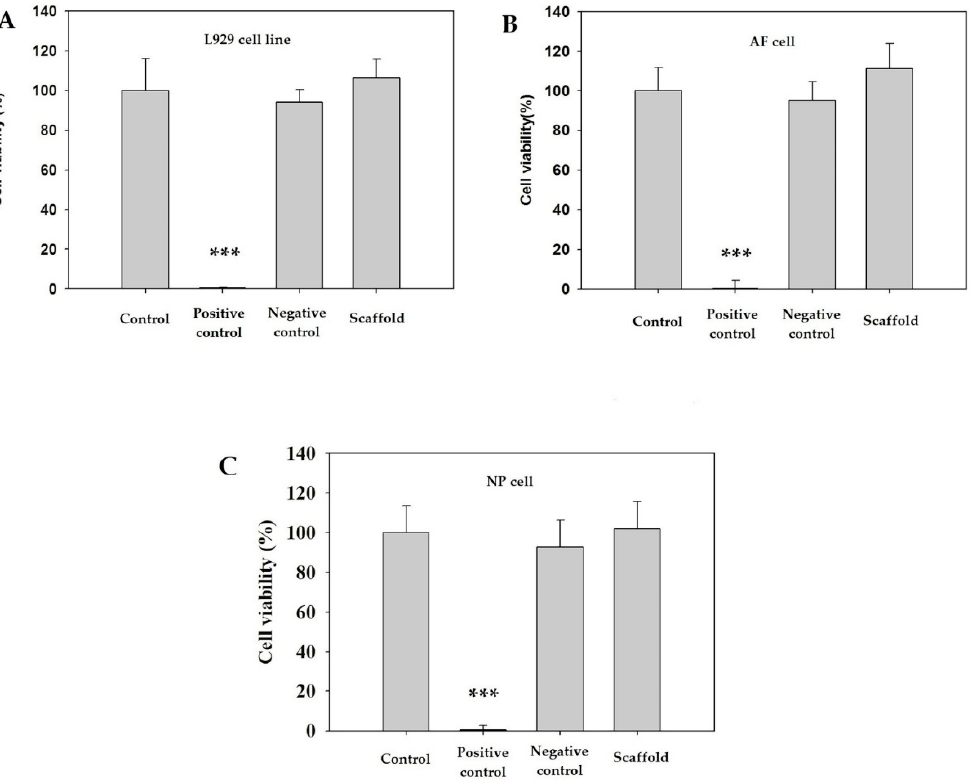
Figure 5. The results of WST-1 assay ratio of different cells with fibroin/gelatin electrospun membrane: ( A ) L929 cell line; ( B ) primary AF cell; ( C ) primary NP cell. Extraction of zinc diethyldithiocarbamate (ZDEC) and aluminum oxide was treated as positive control and negative control. ***: p < 0.001 by t -test ( n = 6).